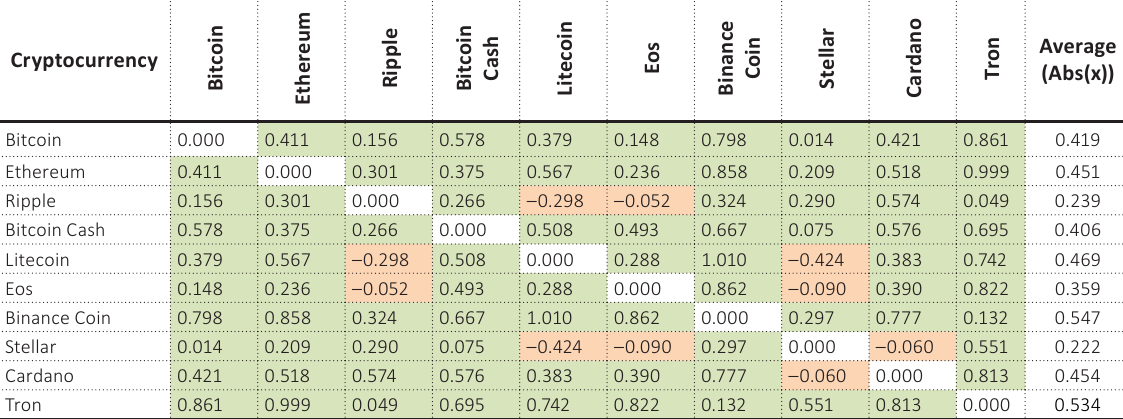
Table 7. Difference in value of correlation coefficients between the periods of increasing and decreasing prices (weekly return)